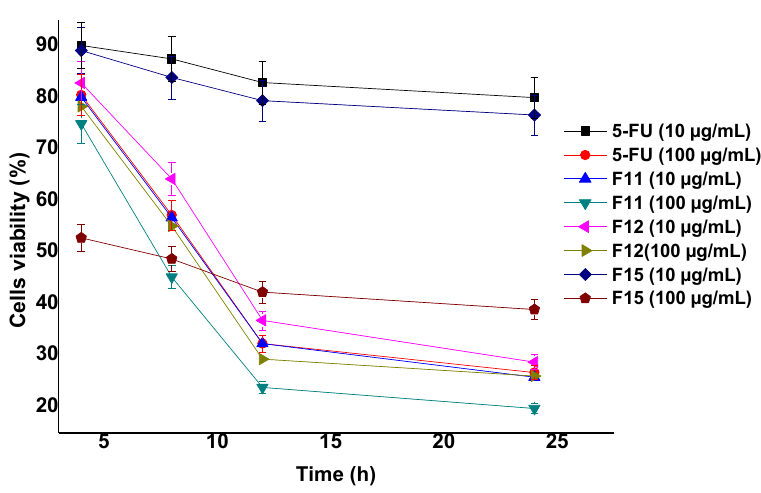
Figure A1. Cell viability (%) of MCF-7 cells (MTT assay: Concentration (10 and 100 mcg/mL) and time (4, 8, 12, and 24 h) dependent cytotoxicity potential of the optimized formulations.